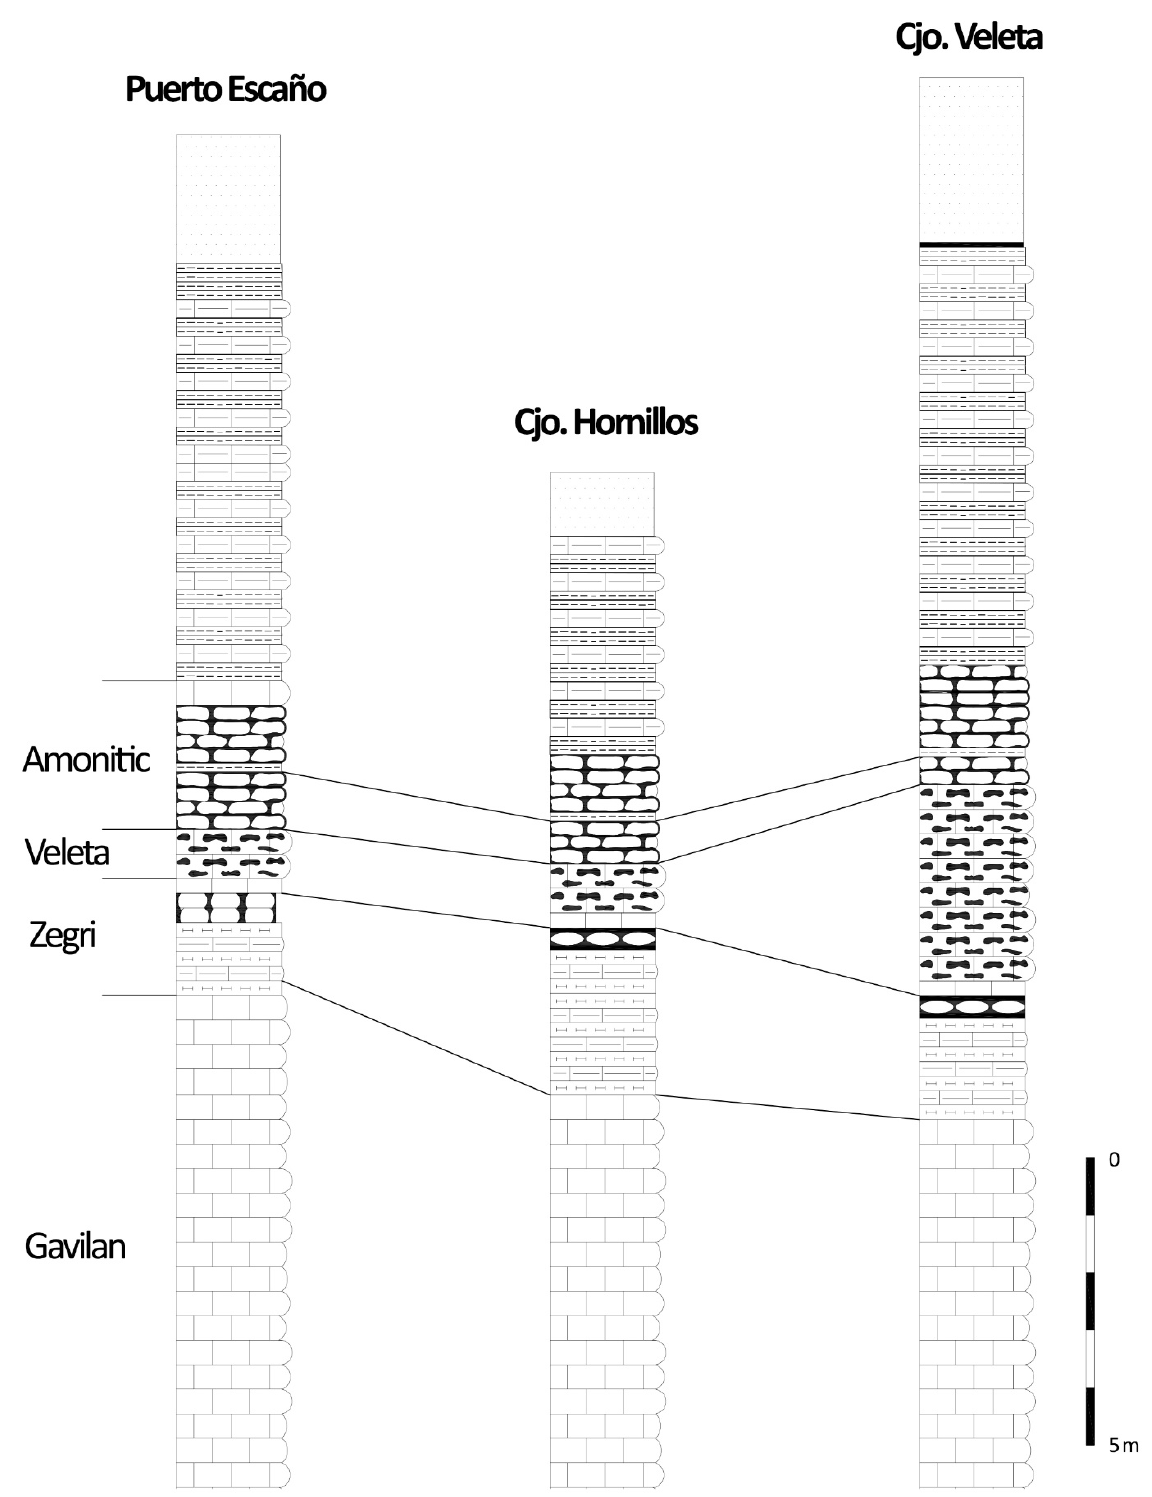
Figure 5. Stratigraphic columns of Gavilan, Zegri, Veleta and Amonitic Formation. (Prepared by the authors, based on Molina (1987).) The scale bar on is 5 m tall (divided into 1_ m